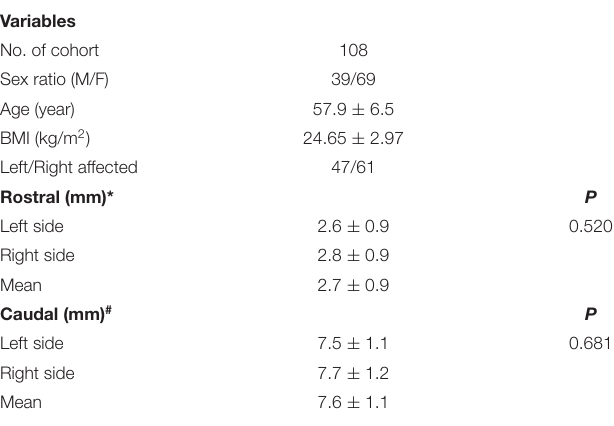
TABLE 1 | Demographic and study data of patients with HFS enrolled in the